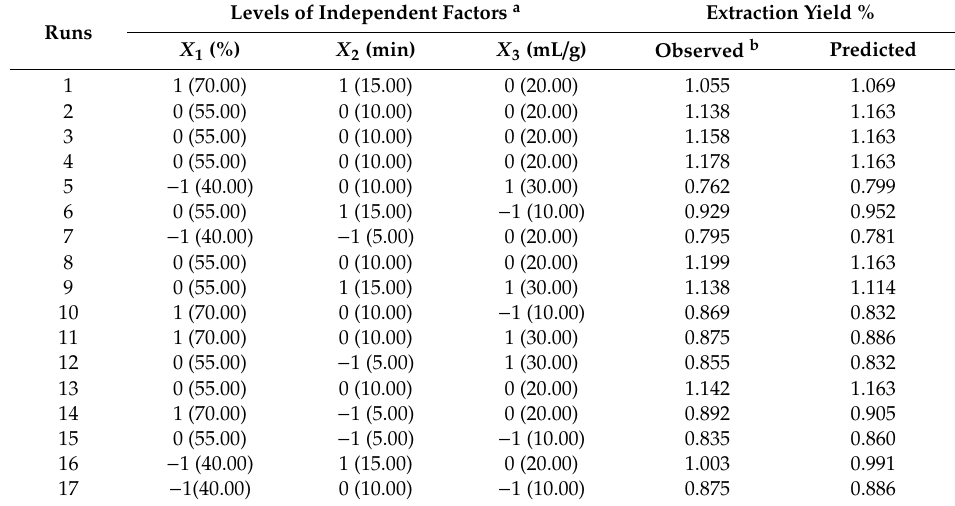
Table 1. Box–Behnken design with independent variables and observed and predicted values. Levels of Independent Factors a Extraction Yield Runs